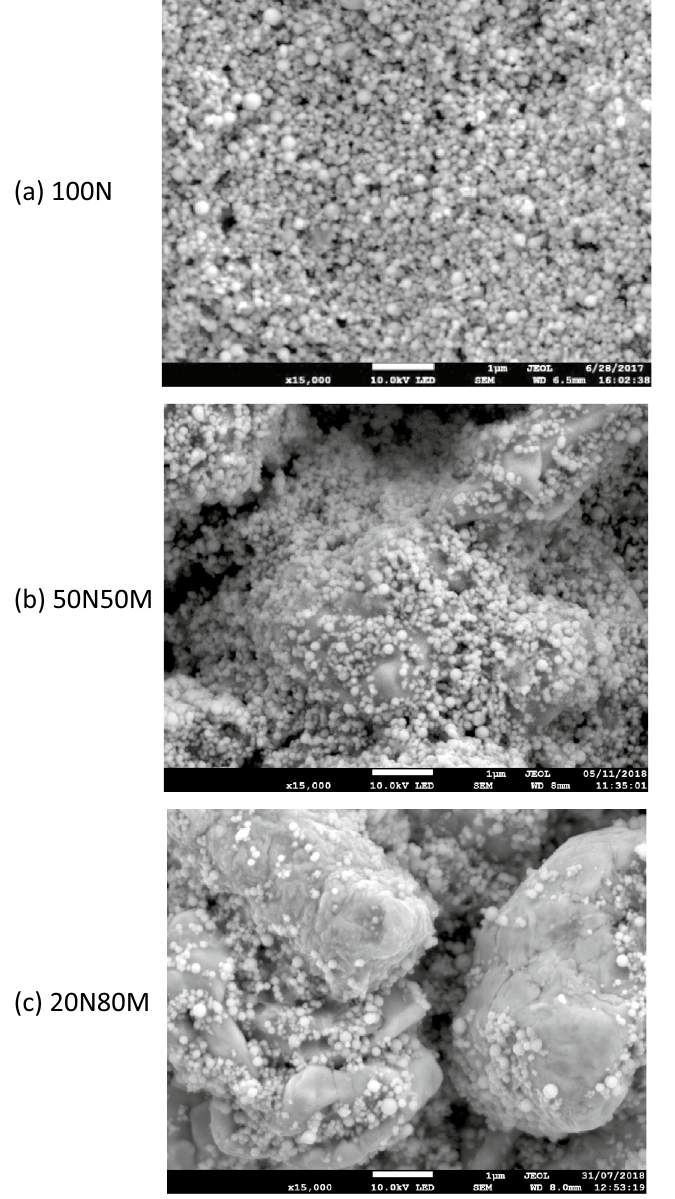
Figure 1. Dry screen-printed